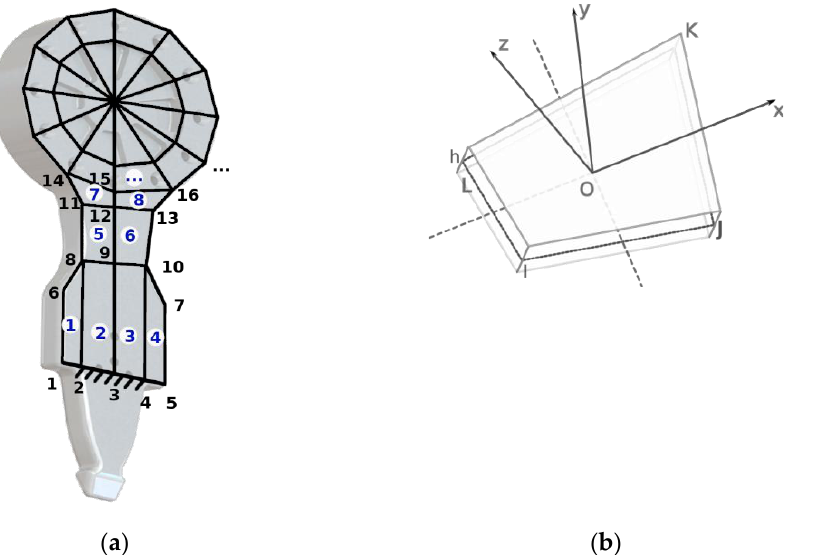
Figure 2. ( a ) The finite element mesh for the device; ( b ) Thin plate-type quadrilateral finite element used in discretization.